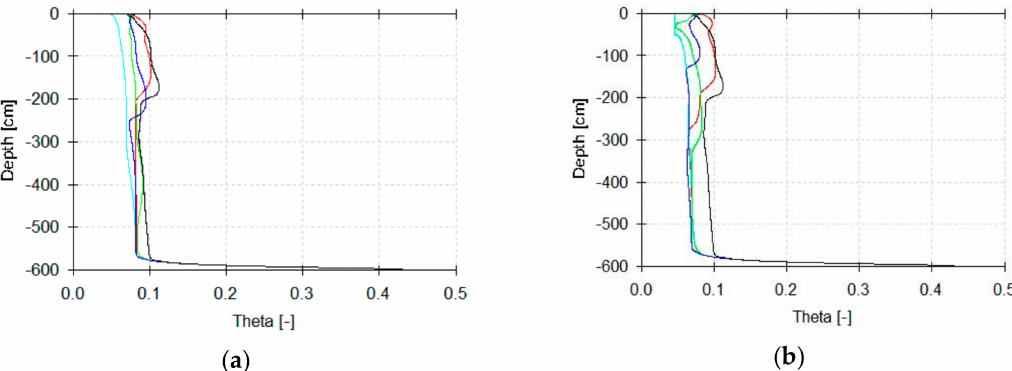
Figure 1. Volumetric water content profiles obtained from HYDRUS-1D simulations for bare sand ( a ) and sand with grass cover ( b ). Initial profiles shown in black, dark blue, green, light blue and red correspond to the end of the first, second, third and fourth year of the simulation,